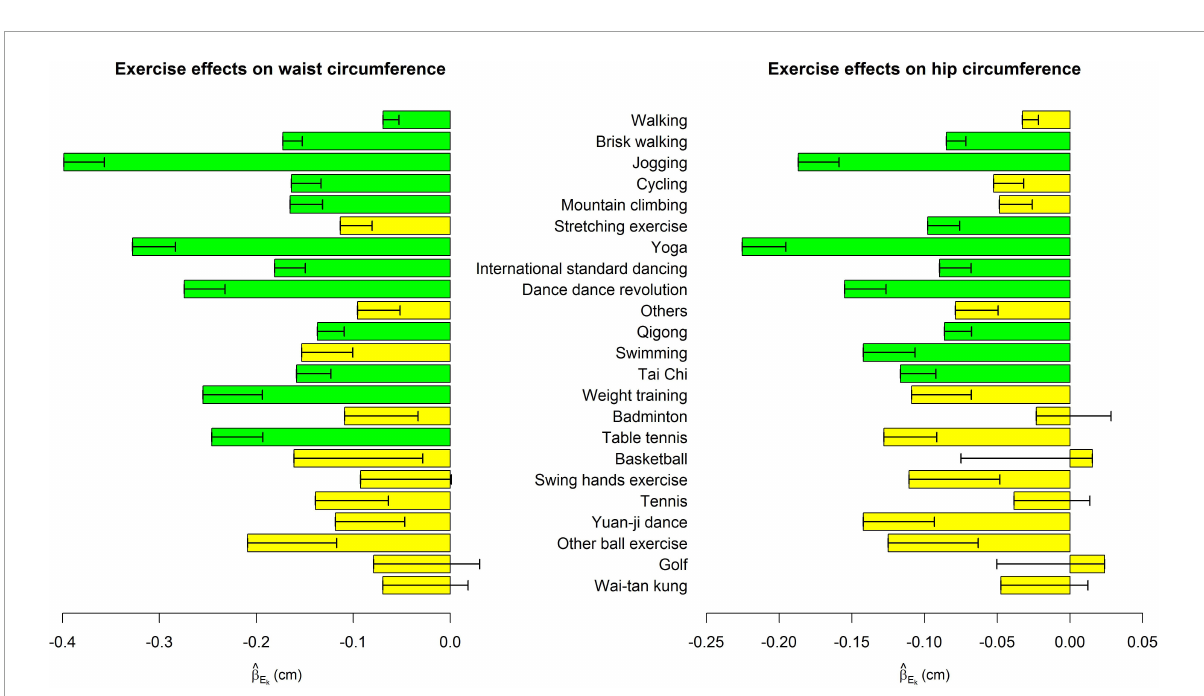
FIGURE2 Exercise main effects on waist circumference and hip circumference. The bars represent ˆ β E standard error of ˆ β E , where k = 1, ... , 23. Bars with p < 0.0004 = 0.05/(23 × 5) were highlighted in green k